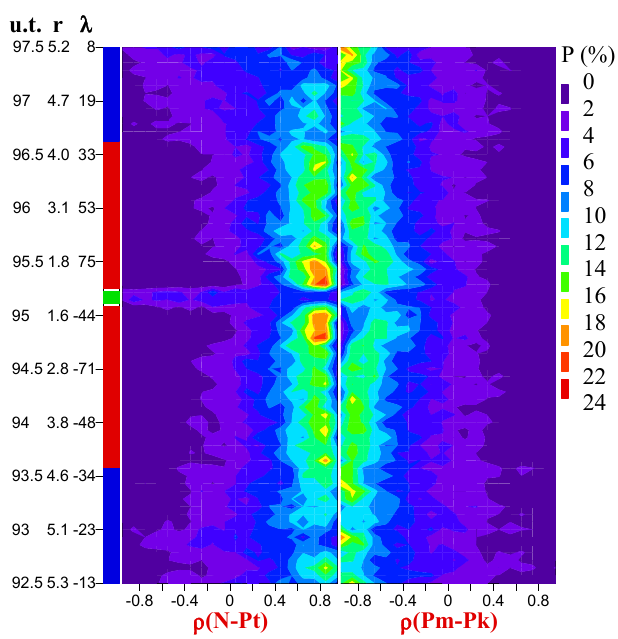
Figure 75: Histograms of 𝜌 ( 𝑁 − 𝑃 𝑡 ) and 𝜌 ( 𝑃 𝑚 − 𝑃 𝑘 ) per solar rotation. The color bar on the left side indicates polar (red), mid-latitude (blue), and low latitude (green) phases. Moreover, universal time UT, heliocentric distance, and heliographic latitude are also indicated on the left side of the plot. Occurrence frequency is indicated by the color bar shown on the right hand side of the figure. Image reproduced by permission from Bavassano et al. (2004), copyright